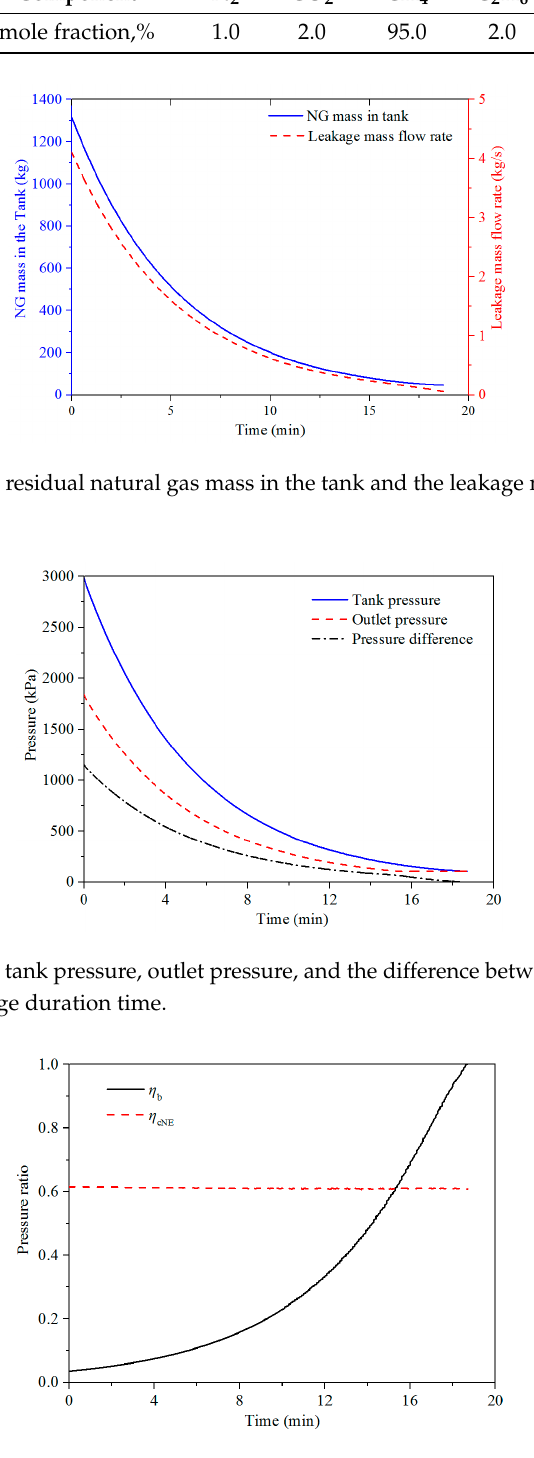
Figure 9. Changes in the critical pressure ratio ( η cNE ) and the outlet pressure ratio ( η b ) over the leakage duration time.